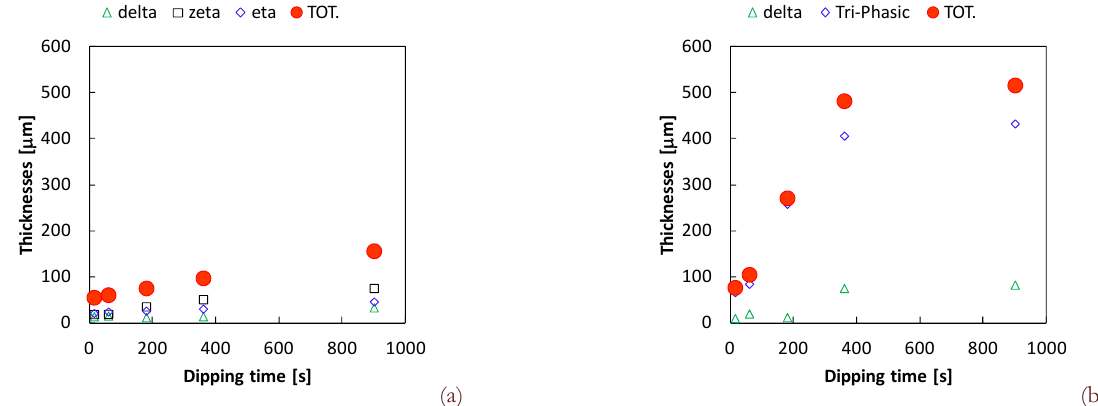
Figure 3: Coatings and their intermetallic phases thicknesses: a) coatings from Zn-Sn bath, b) coatings from Zn-Ti baths. Presence of 3%Sn in the bath covers a linear increase of whole coating thicknesses in the dipping time, while intermetallic  ,  and  phases are characterized by a diffusion phenomenon of growth .